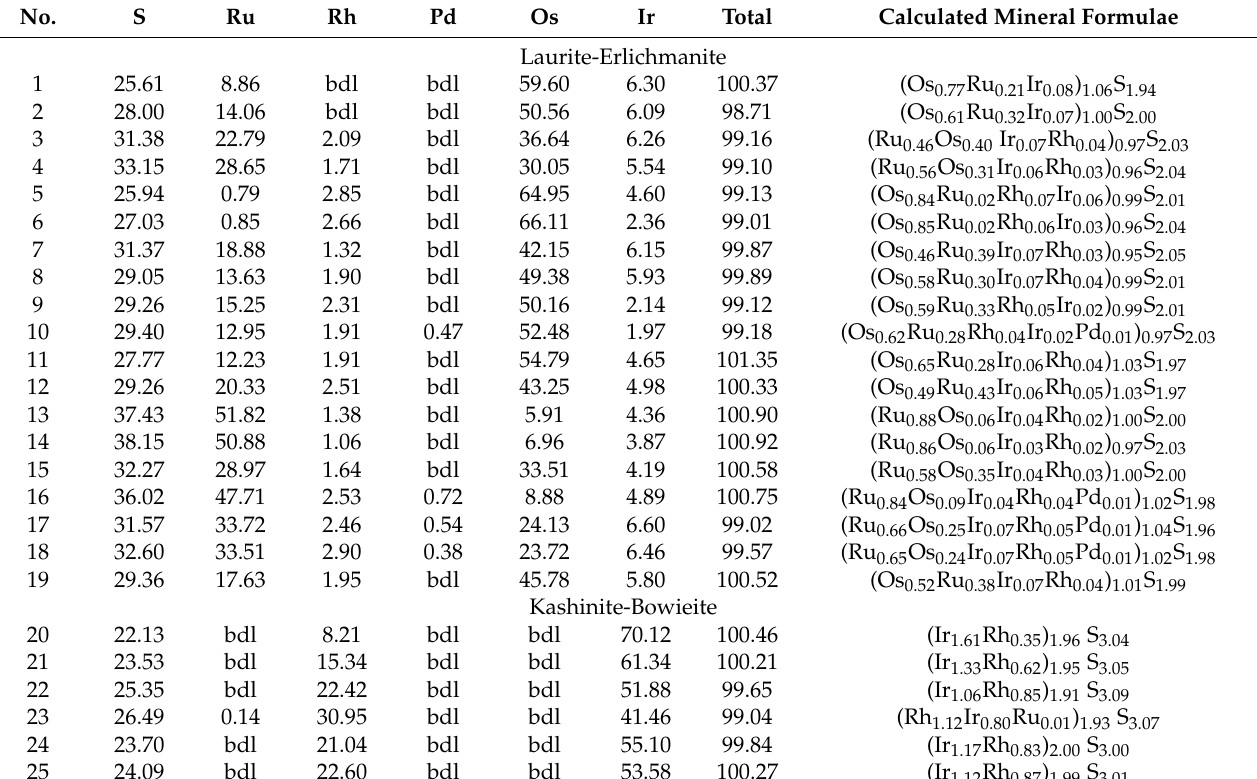
Table 5. The composition of laurite–erlichmanite (1–20) and kashinite–bowieite